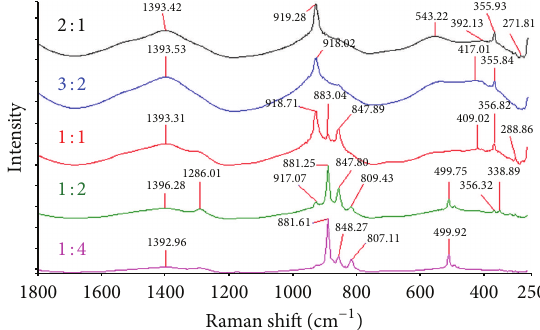
Figure 3: FT-IR spectrum of the synthesized dehydrated magne- sium borate minerals at 1000 ∘ C and 240 minutes of reaction time.